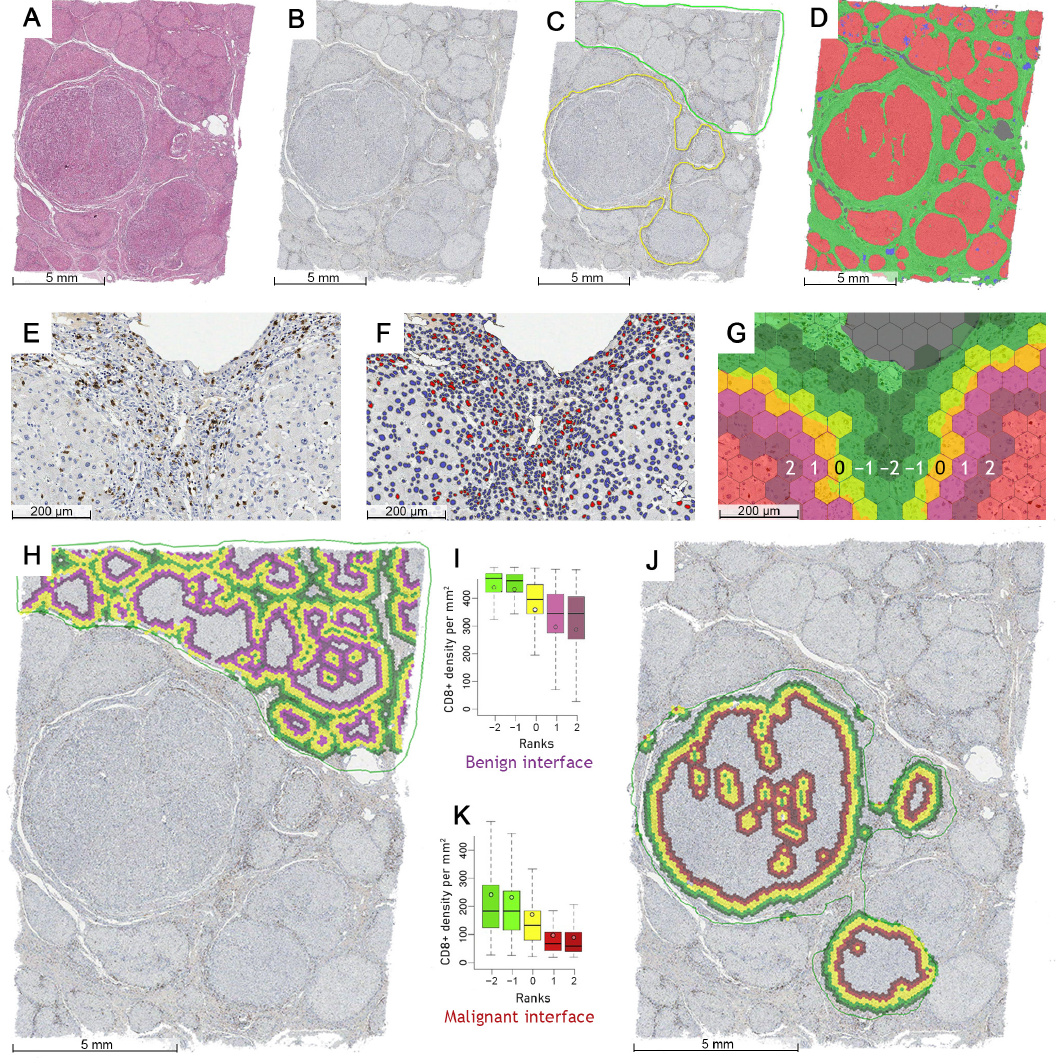
Figure 1. Study workflow (stroma interfaces with neoplastic (HCC) tissue and non-malignant liver parenchyma sampled to assess CD8+ cell density profiles): ( A ) low magnification view of the whole H&E stained tissue sample containing HCC nodules and the surrounding cirrhotic liver parenchyma; ( B ) a matching CD8 immunohistochemistry slide that was further used for analysis (see panel E and Supplementary Figure S1A,B for higher magnification); ( C ) a sample of manually annotated HCC and non-neoplastic liver areas, avoiding ambiguous or artifact-containing zones; ( D ) HALO ® AI epithelium versus stroma segmentation: both malignant and non-malignant hepatocytes—red, stroma—green, debris and artifacts—blue, background—gray; ( E ) magnified detection zone on a CD8 slide, positive cytotoxic T lymphocytes—brown cytoplasmic staining; ( F ) Multiplex IHC ® nuclei segmentation masks, CD8 positive cells—red, CD8 negative cells—blue; ( G ) identification of the epithelial edge (yellow hexagons, rank 0), epithelial aspect (red hexagons, ranks 1–2) and stromal aspect (green hexagons, ranks − 1 and − 2) of the interface zone (ranks from − 2 to 2) based on a hexagonal grid; ( H ) the benign (liver) interface zone, epithelial aspect (i.e., liver parenchyma)— purple, epithelial edge—yellow, stromal aspect—green; ( I ) an example boxplot showing a decrease of average CD8+ cell density per rank towards the epithelial aspect of the benign interface zone; ( J ) the malignant (HCC) interface zone, epithelial aspect (i.e., HCC)—red, epithelial edge—yellow, stromal aspect—green; ( K ) an example boxplot showing the decrease of average CD8+ cell density per rank towards the epithelial aspect of the malignant interface